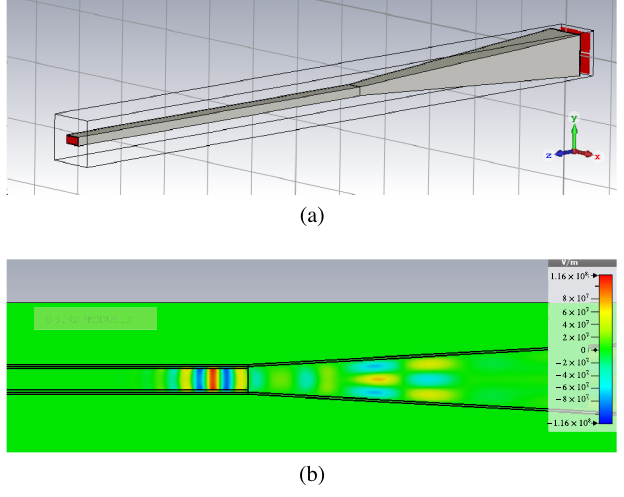
FIG. 17. (a) The 30 mm long rectangular structure with the 23 mm coupler section used in a CST benchmarking study. (b) Longitudinal electric field excited in the structure. The beam travels from right to